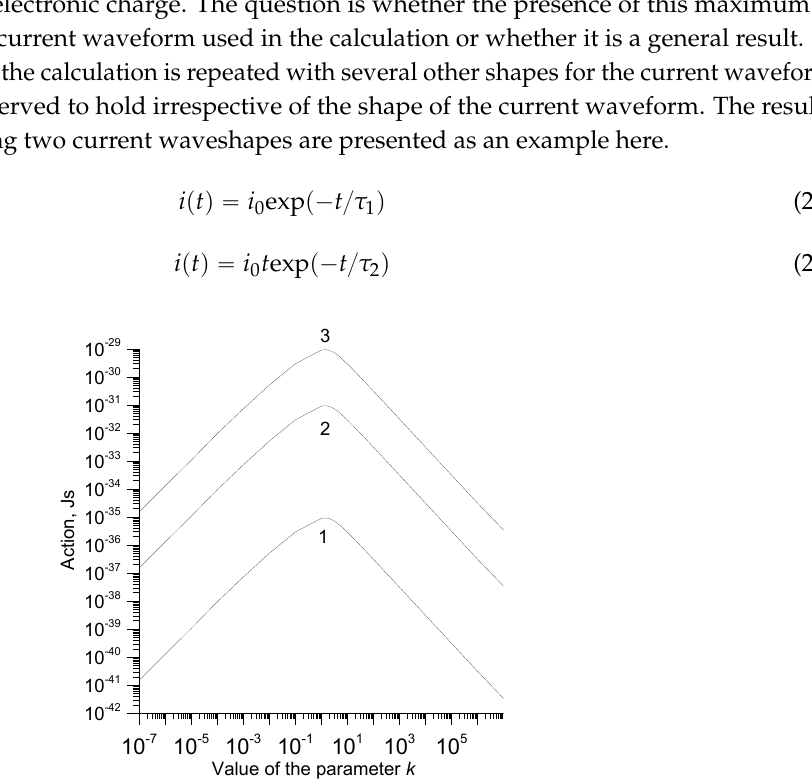
Figure 8. The action, as a function of k , for different values of charges. The current used in the calculation has the half sine waveshape. (1) q = 1e ; (2) q = 100e ; (3) q = 1000e . Note that e is the electronic charge.